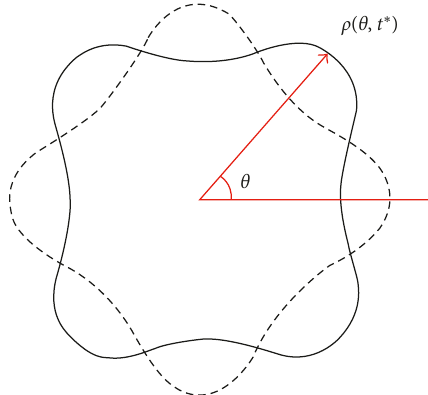
Figure 7: The liquid and gas pressure at n � 4, when R f � 130kHz, and P d � 42kPa.